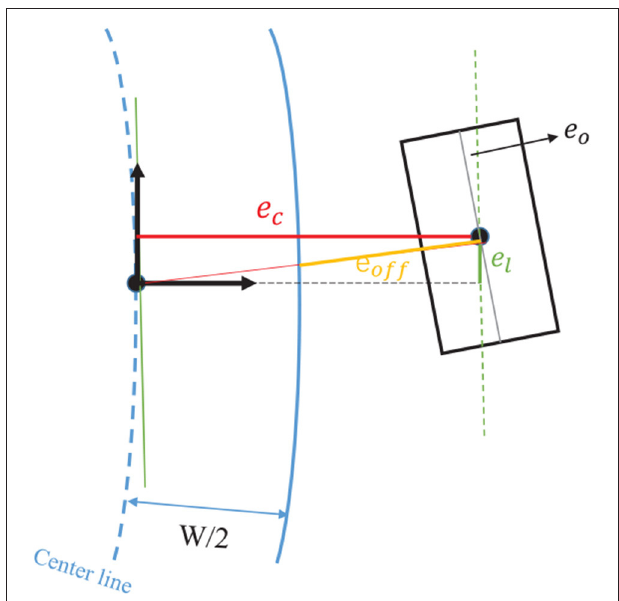
FIGURE 4 | Lag-, contour-, orientation-, and offset error. The vehicle model is intentionally plotted outside the road boundary to show these errors clearly.